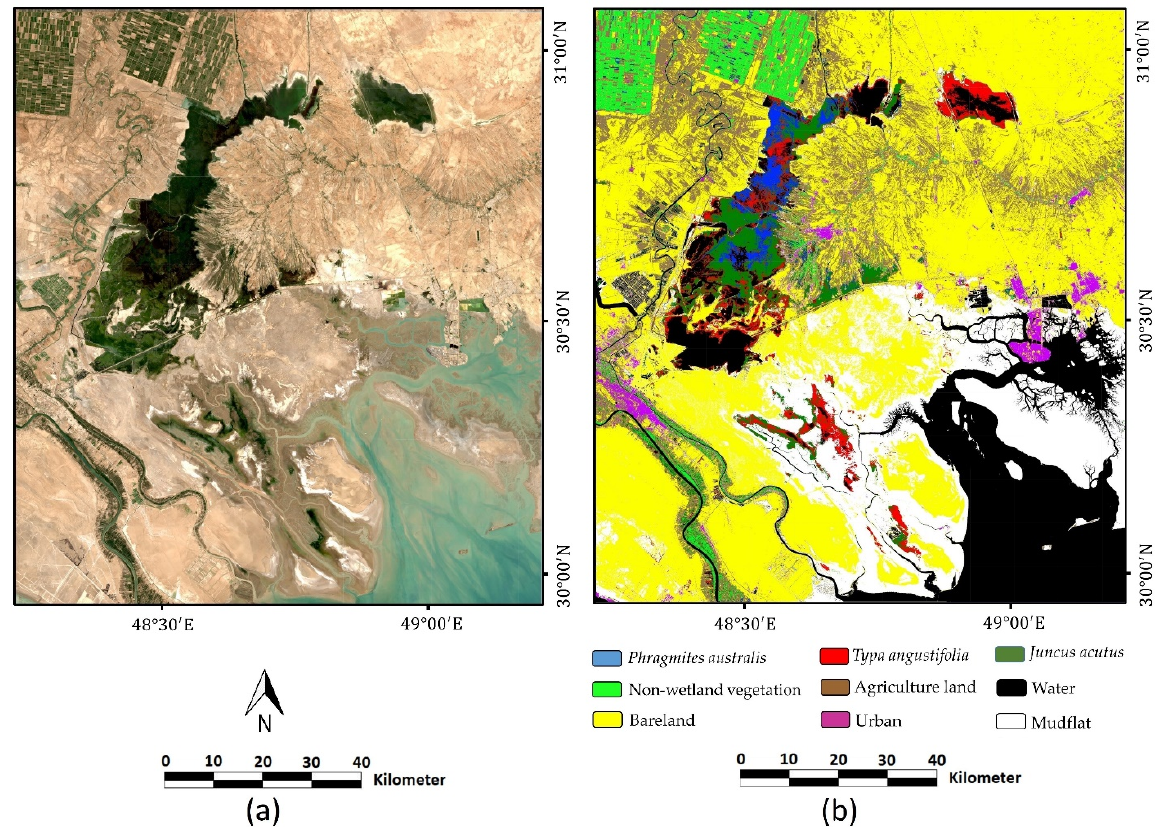
Figure A4. growing season mosaic of the target year of 2019 ( a ) and wetland map of target year of 2019 using migrated samples ( b ).